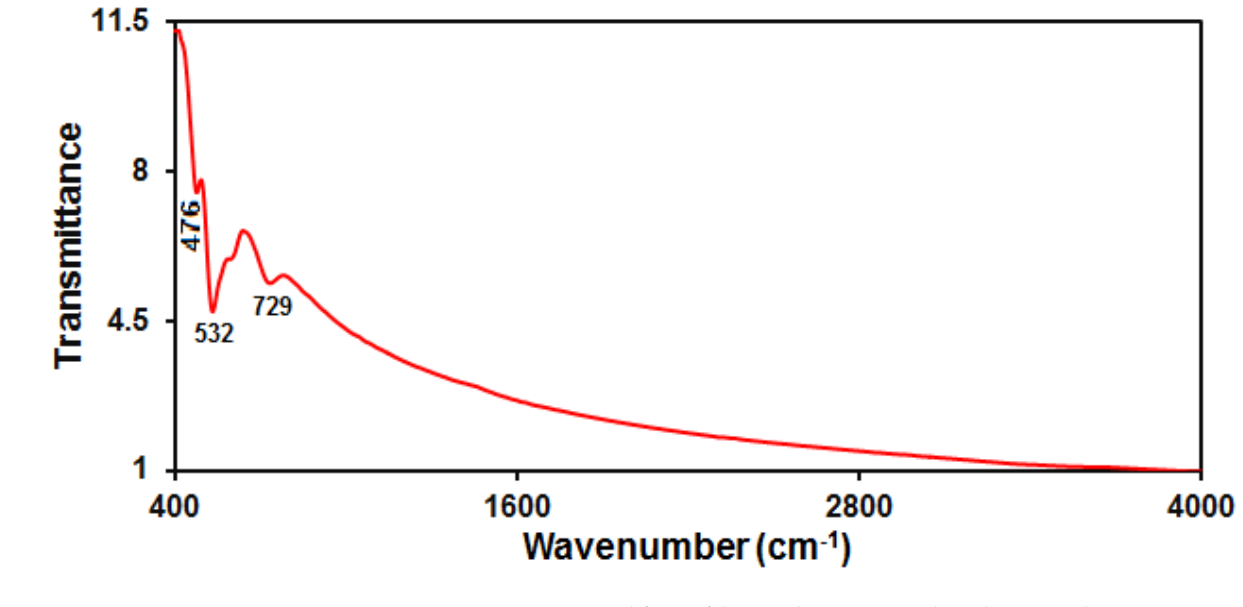
Figure 3. FT-IR pattern captured for as-fabricated manganese dioxide nanorods.